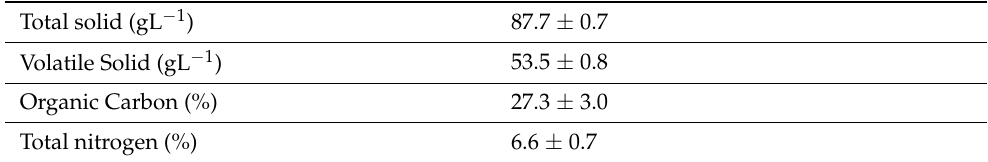
Table 1. Characterization of the SPW used as substrate in the AD experiment. SD values are also